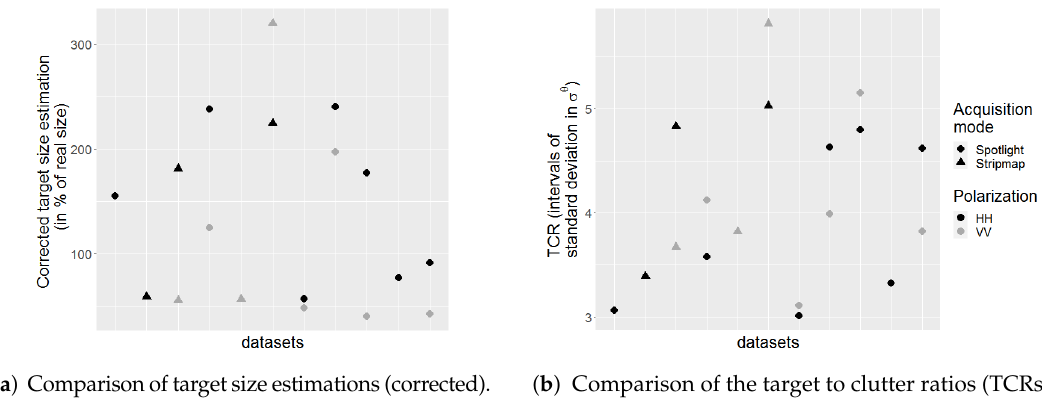
Figure 15. Impacts of scene and sensor settings on the quality of identification.